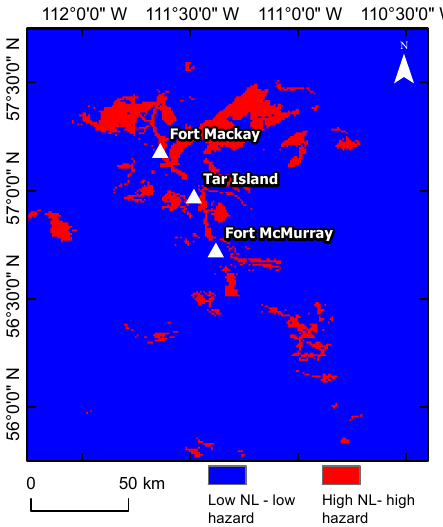
Figure 1. Locations indicating increase in nightlight (NL) activity over high-hazard areas between the years 1992 and 2013 (DN 2013 – DN 1992 )